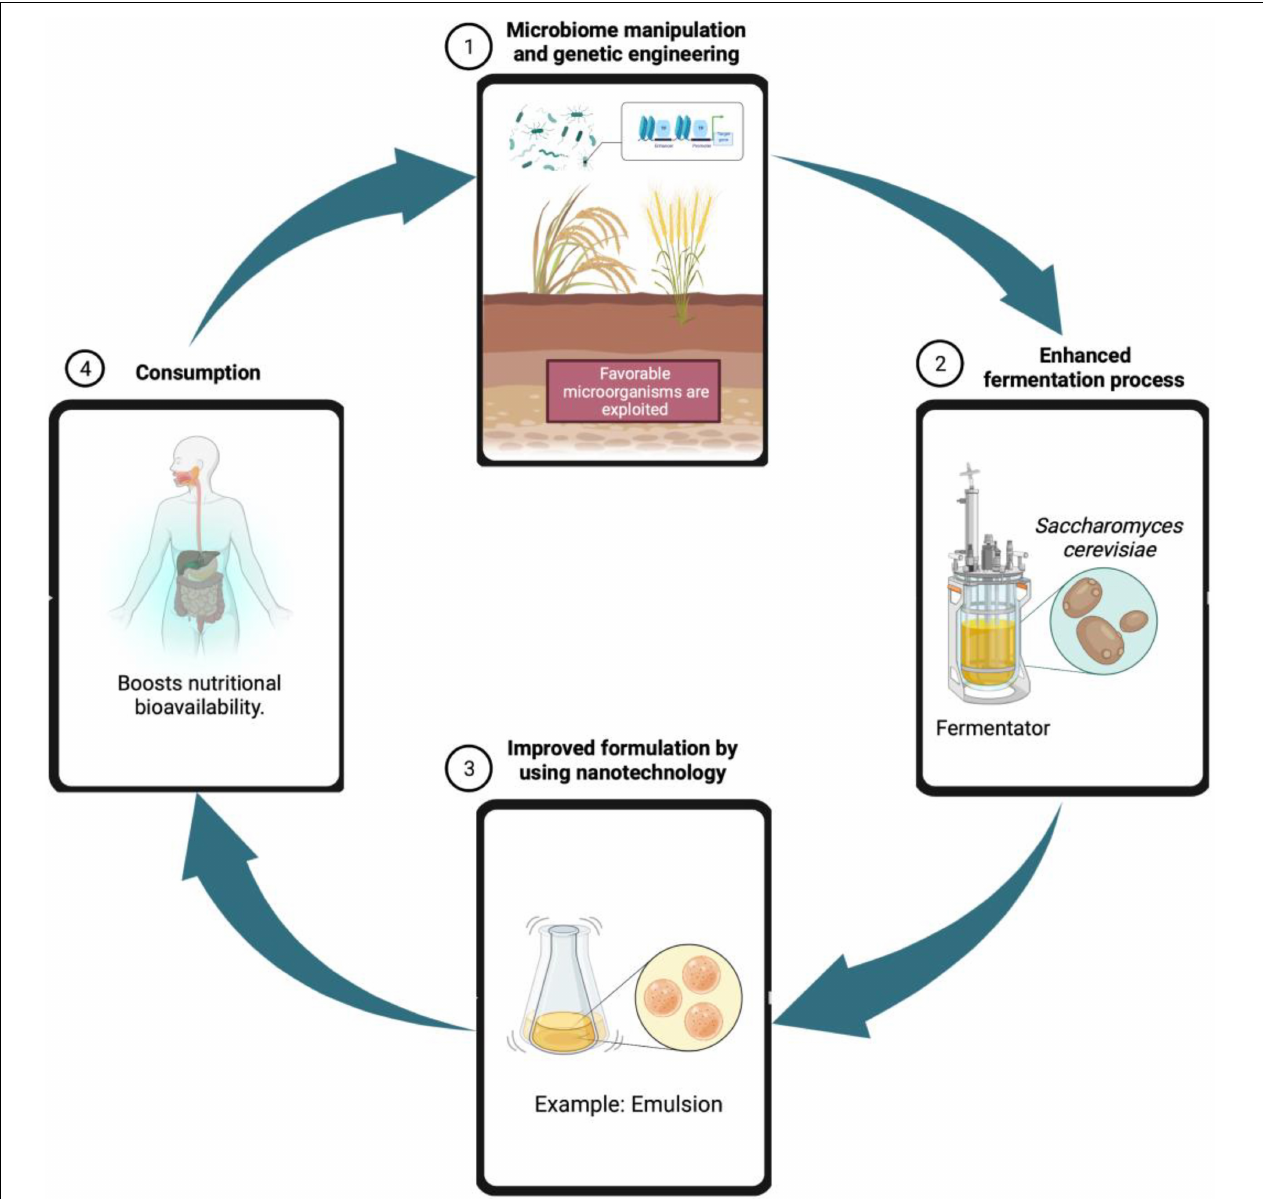
FIGURE 8 | Future prospects for maximizing nutritional value of rice beer through genetic engineering, enhanced fermentation processes, and